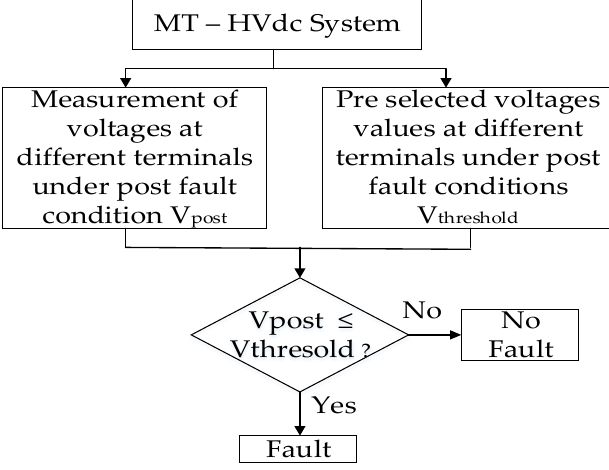
Figure 25. Non-traveling wave (NTW) method based on under voltage values.